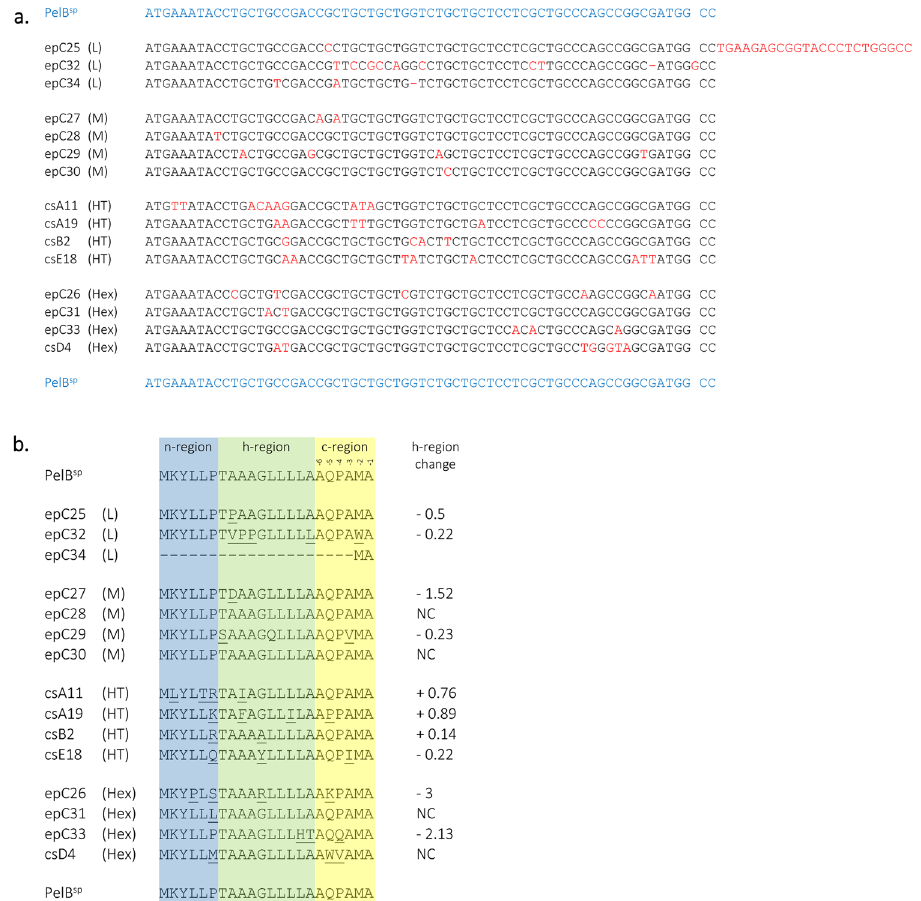
Figure 6. Sequence alignment of the signal peptides selected from epPCR and CS libraries. ( a ) Nucleotide sequence alignment; mutated bases are shown in red. L, M, HT and Hex refer to the β -lactamase activity conferred by the signal peptides: low, medium, high transporting and high expression respectively, see text for details. ( b ) Peptide sequence alignment. Signal peptides regions are highlighted. Underlined resides are those mutated. ‘h-region change’ states the change in hydrophobicity of the h-region, calculated using values from 34 . NC: no